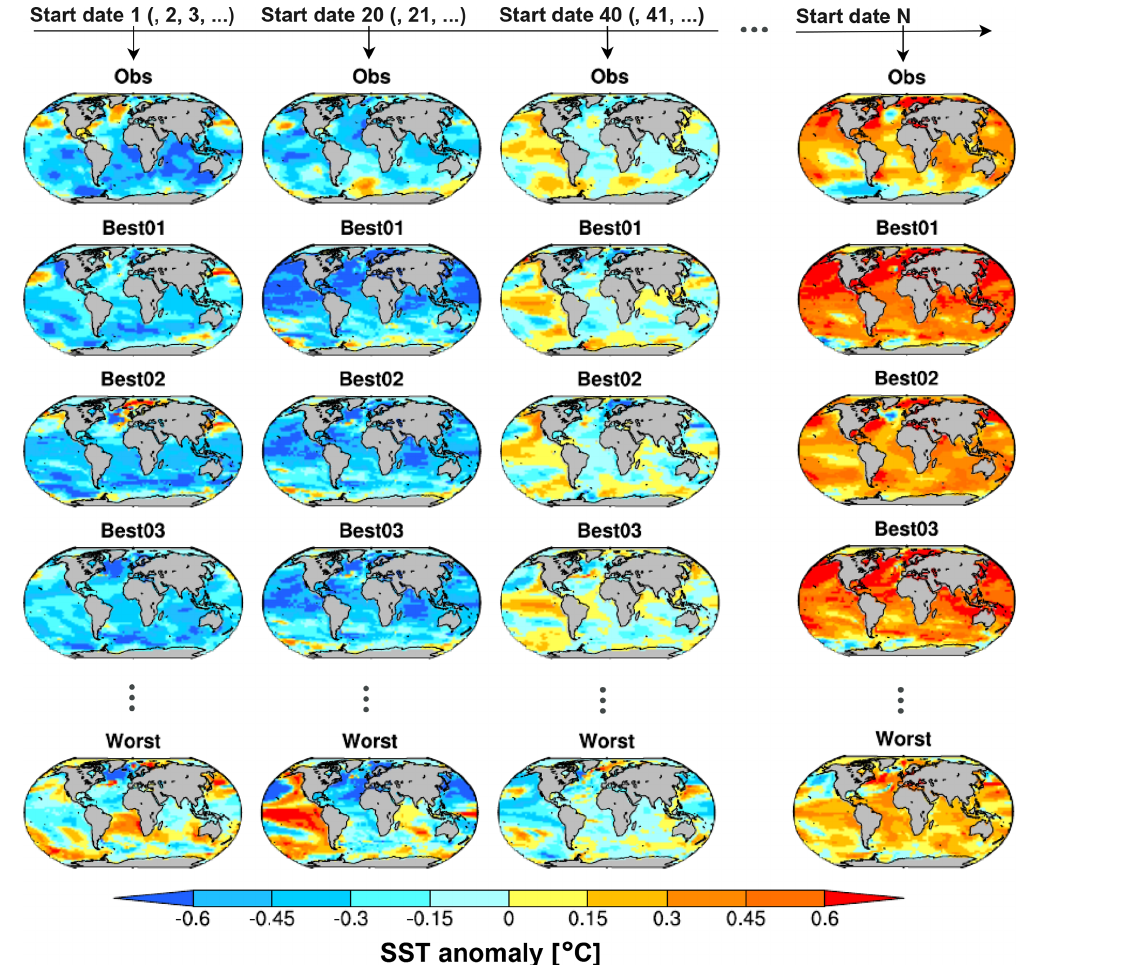
Figure 1. A schematic illustration of the constraining methodology in which observed SST anomaly patterns (as in the top row) are used to compute spatial pattern correlations with individual historical ensemble members. Based on these pattern correlations, the historical ensemble members are ranked from the one with the best agreement with the observed state (e.g., Best01, Best02, Best03) to the worst agreement. For conciseness, we only show here the observed and the ranked historical member anomaly patterns of four start dates, however this ranking procedure is repeated every year using 9-year average SST anomalies prior to starting a prediction. For each start date, we select the 30 top ranking members to make predictions on decadal to multi-decadal